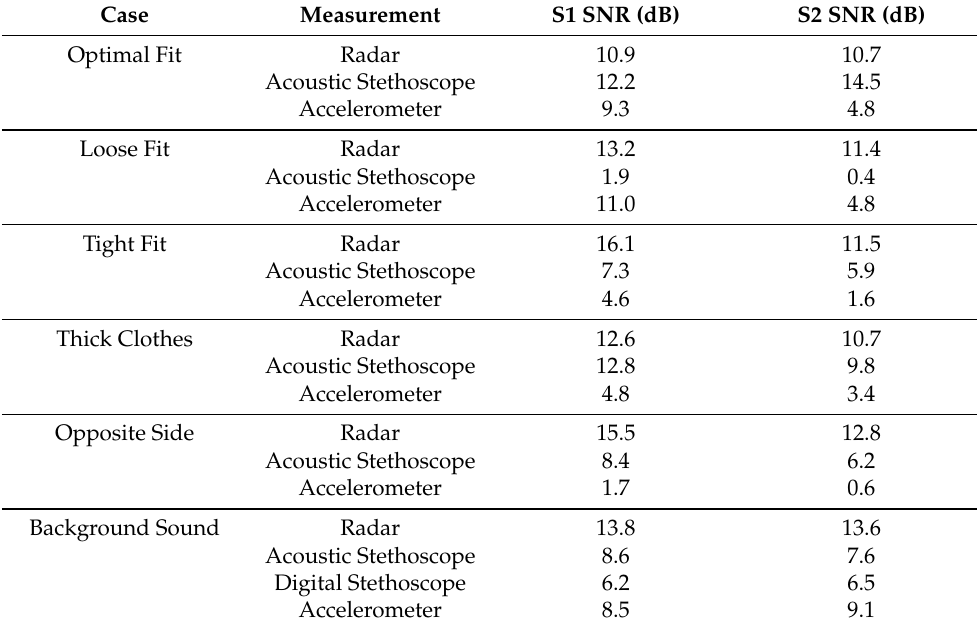
Table 2. The SNRs for the first and second heart sounds for each measurement under each test case.